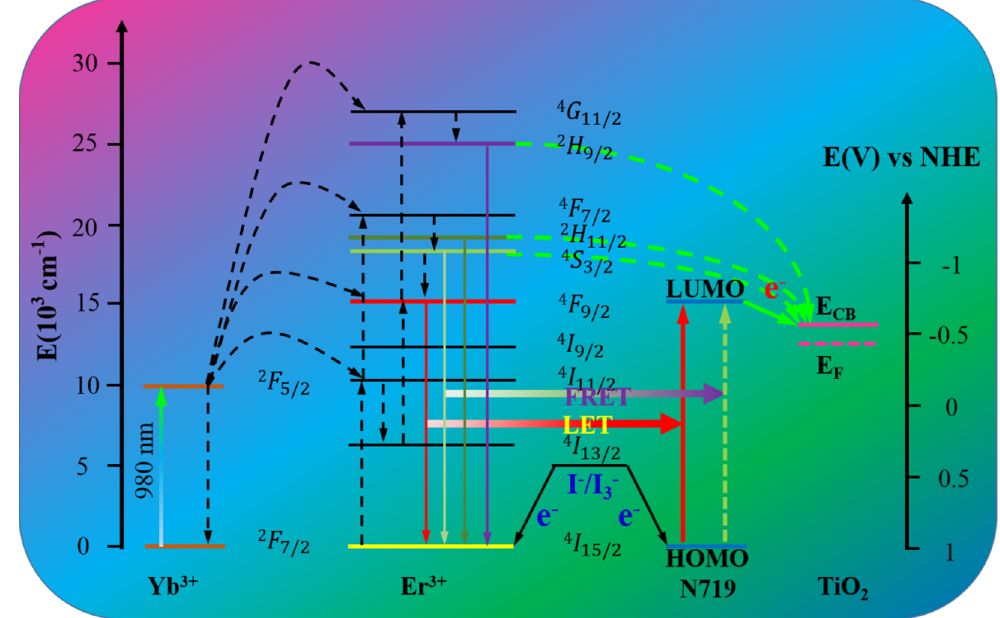
Figure 10. A cartoon illustration of energy transfer mechanisms in upconversion nanoparticles (UCNPs)-Doped DSSCs. This figure shows the absorption and conversion of near infrared (NIR) photons into visible light of higher energy via upconversion; the electron transfer from UCNPs to the conduction band of TiO 2 , as well as the electron transfer from I − /I 3 − to the ground state of UCNPs. FRET and LET are fluorescence resonance energy transfer and luminescence-mediated energy transfer, respectively. HOMO and LUMO are highest occupied molecular orbital and lowest unoccupied molecular orbital,